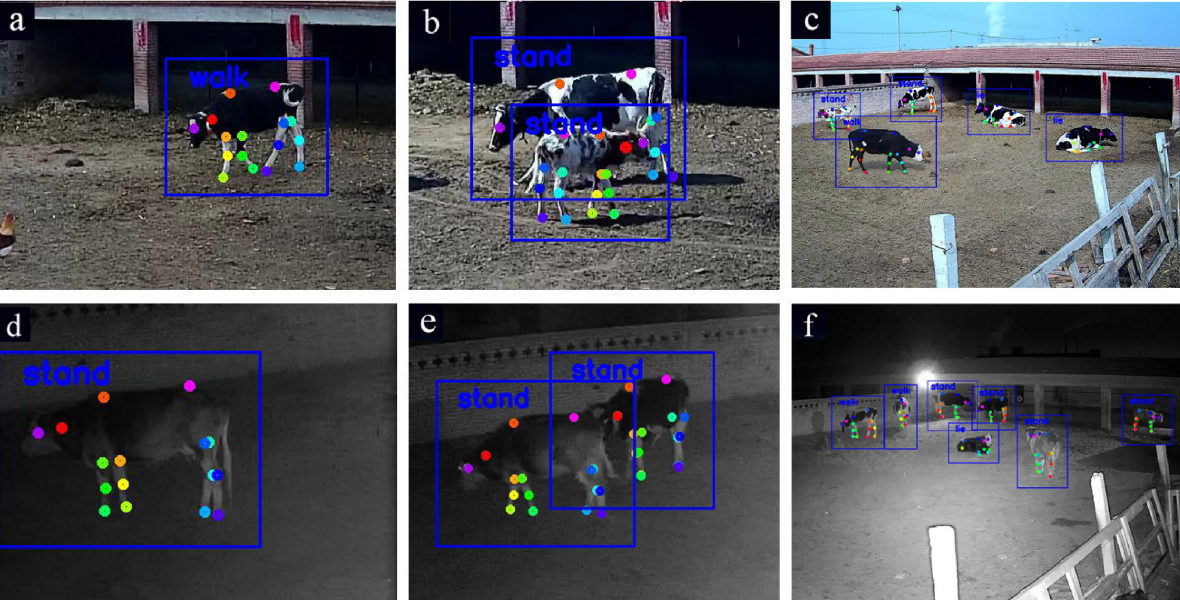
Fig 9. Effects of different numbers of cows on pose estimation. (a)-(c) indicate the image containing single cow, double cows and 5 cows during the day. (d), (e) and (f) represent the image containing single cow, double cows and 6 cows at night.